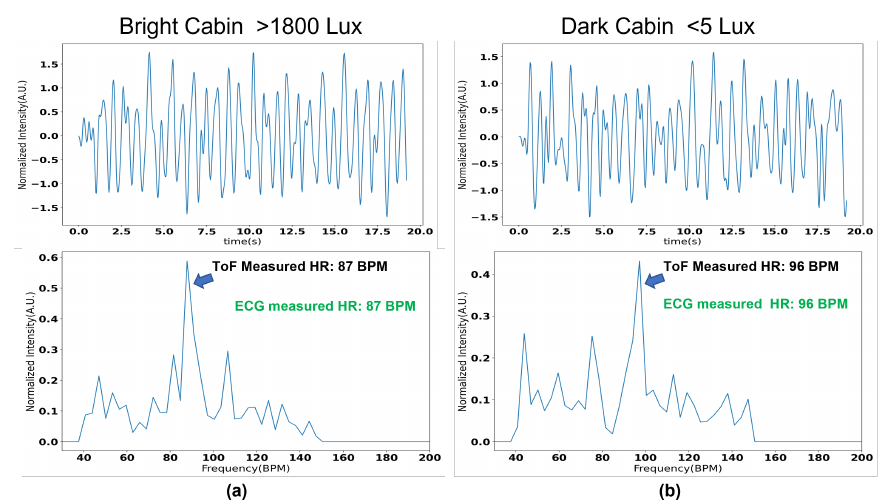
Figure 7. Time ( Top ) and frequency ( Bottom ) domain of the motion-compensated HR signal in both bright ( a ) and dark ( b )